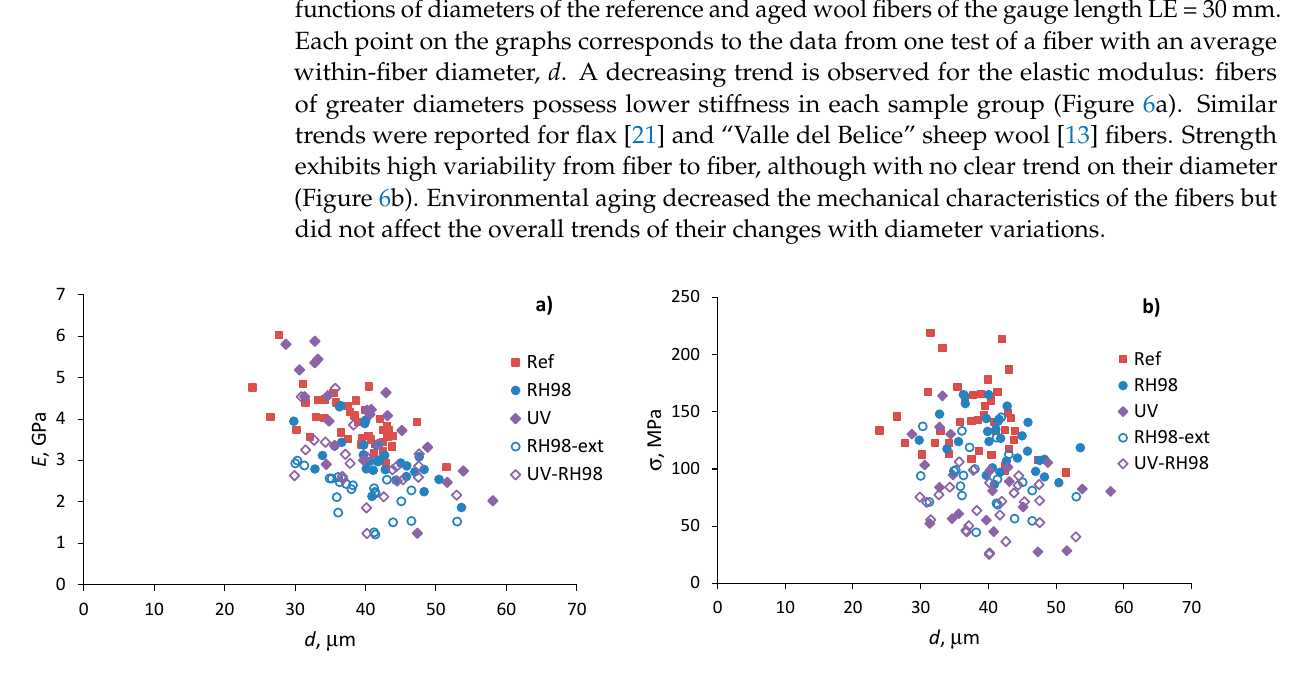
Figure 6. Elastic modulus ( a ) and strength ( b ) as functions of the diameter of the reference and aged wool fibers; LE = 30 mm.